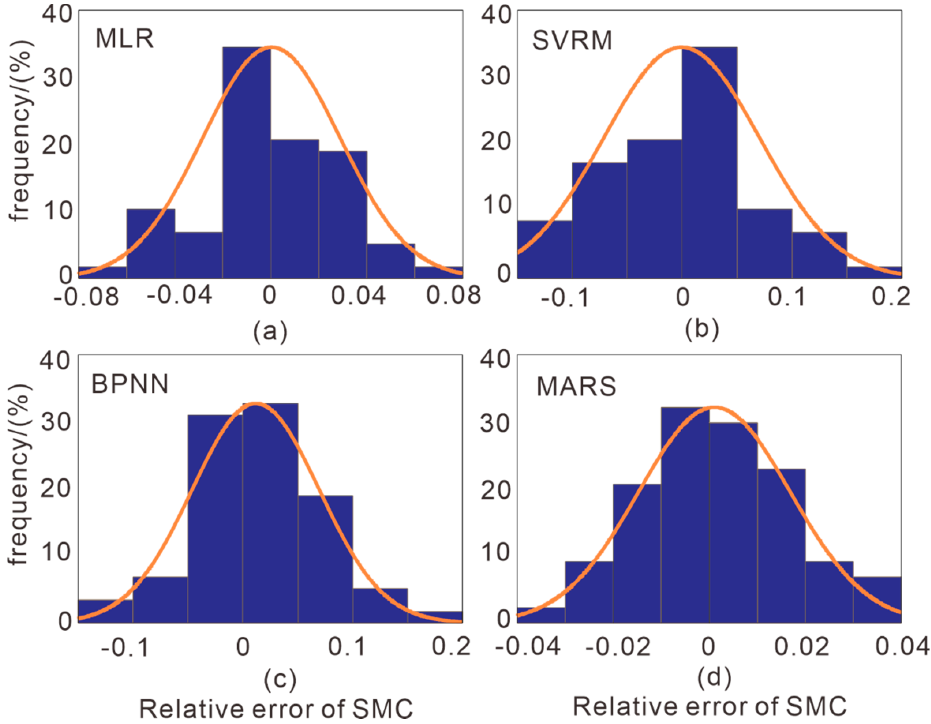
Figure 9. ( a ) Statistical results of the relative error of MLR. ( b ) Statistical results of the relative error of SVRM. ( c ) Statistical results of the relative error of BPNN. ( d ) Statistical results of the relative error of MARS.